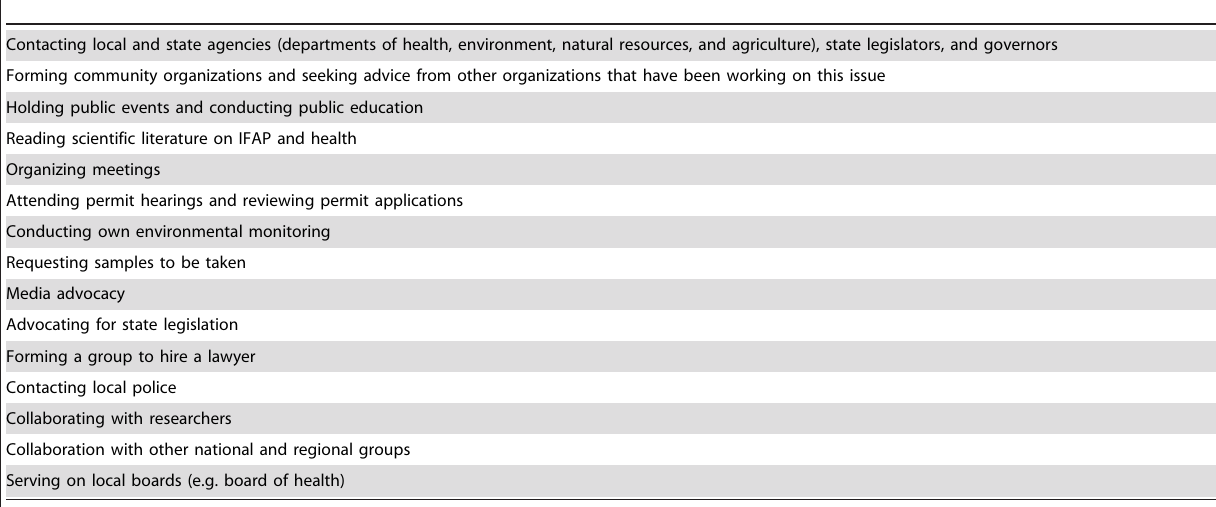
Table 3. Actions taken by community members/groups in response to IFAP concerns.